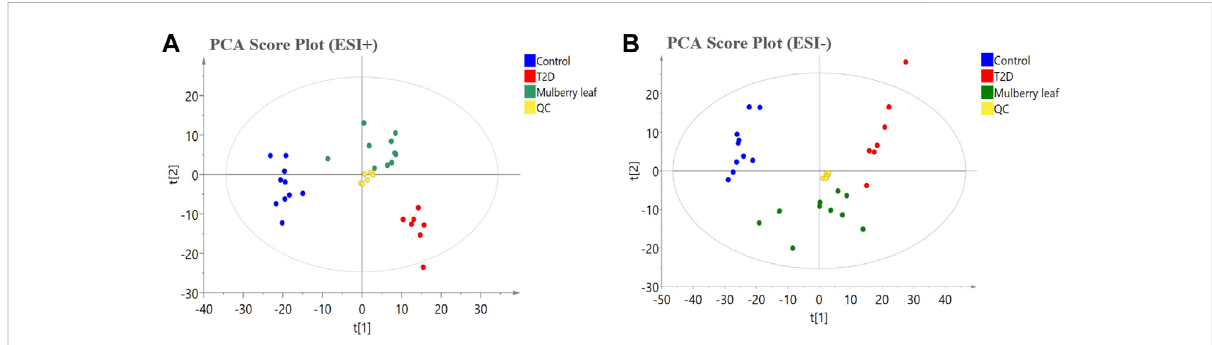
FIGURE 4 The principal component analysis (PCA) score plot of the serum metabolomics analysis (A) ESI + model (B) ESI-